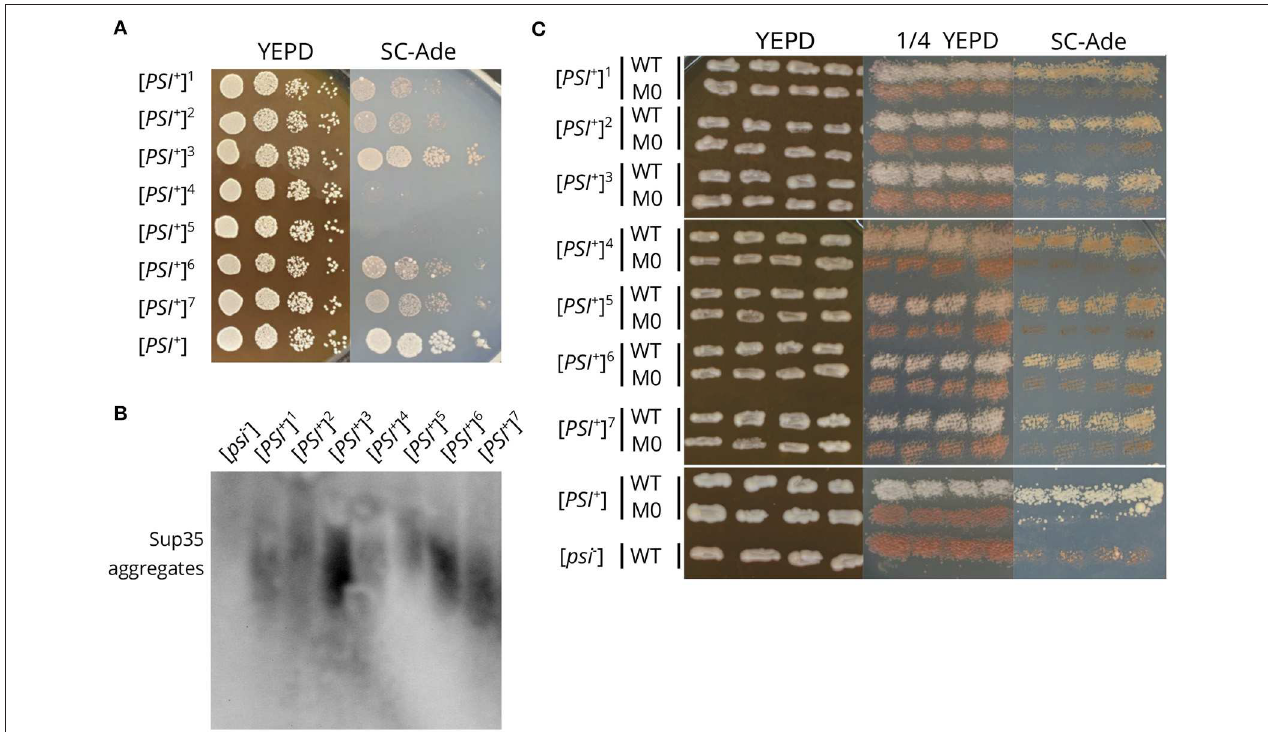
FIGURE 6 | The sup35-M0 mutation destabilizes different [ PSI + ] variants. (A) The suppressor phenotype of the obtained [ PSI + ] variants (designated by numbers 1-7). [ PSI + ] designates the 10-7A-D832 strain. Cells were plated in 10-fold serial dilutions and grown for 3 days on YEPD and 5 days on SC-Ade. (B) The comparison